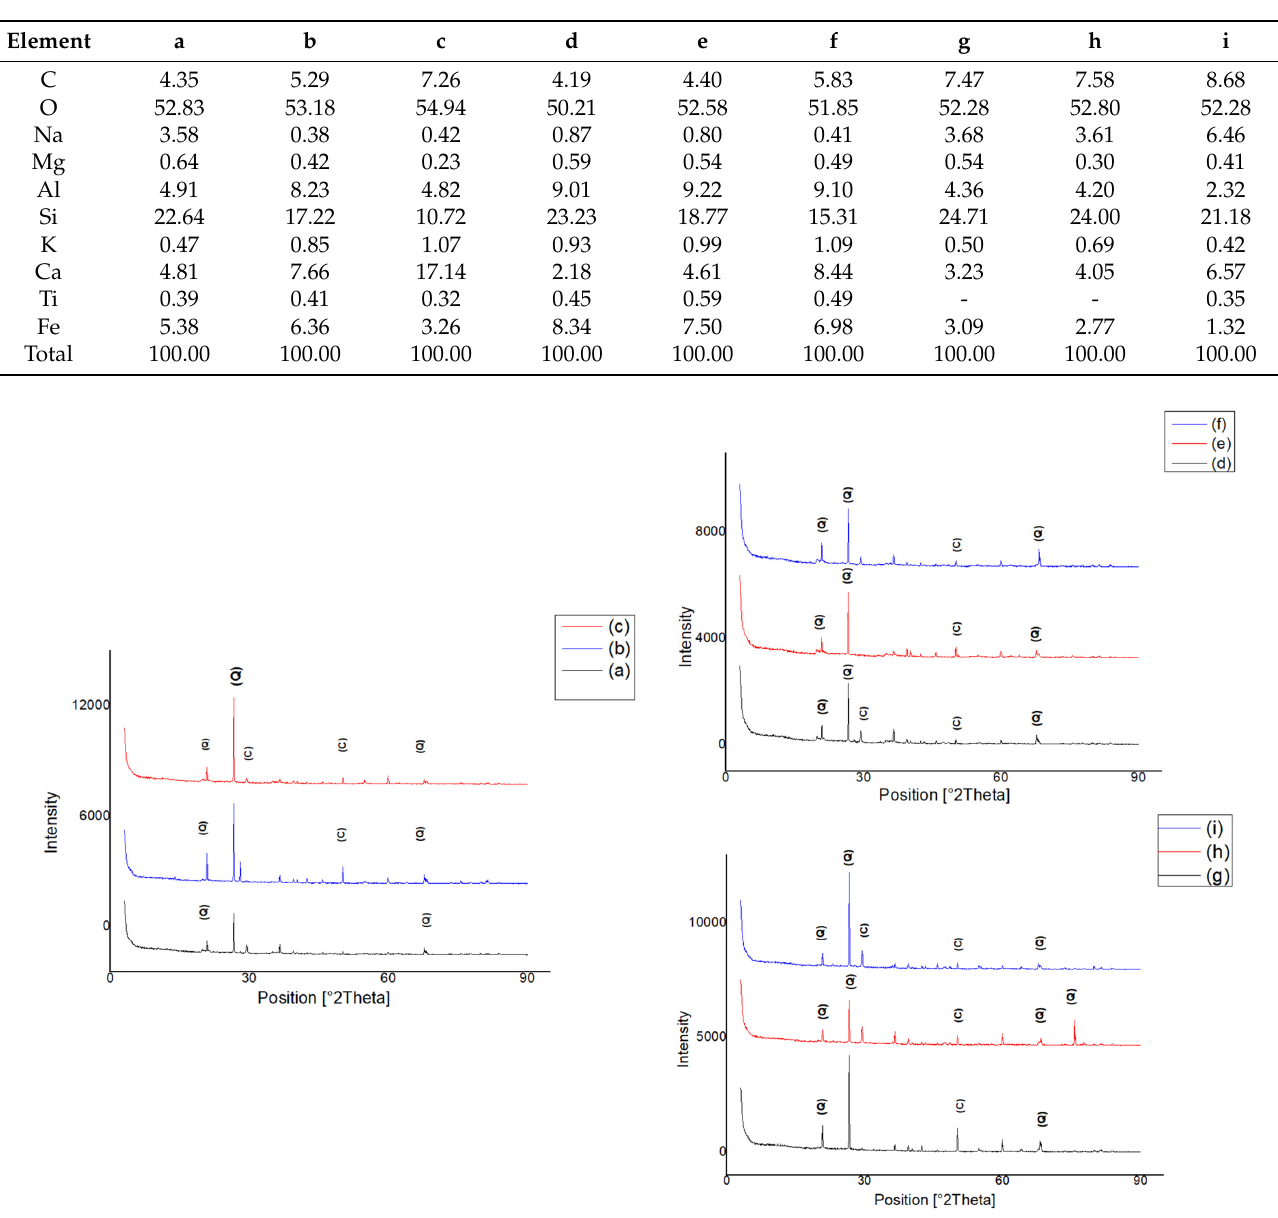
Figure 7. X-ray diffraction patterns: ( a ) control sample (RSB); ( b ) 0% GP + 6% cement; ( c ) 0% GP + 12% cement; ( d ) 10% GP + 0% cement; ( e ) 10% GP + 6% cement; ( f ) 10% GP + 12% cement ( g ) 30% GP + 0% cement; ( h ) 30% GP + 6% cement; ( i ) 30% GP + 12% cement. Q, quartz; C, calcite.